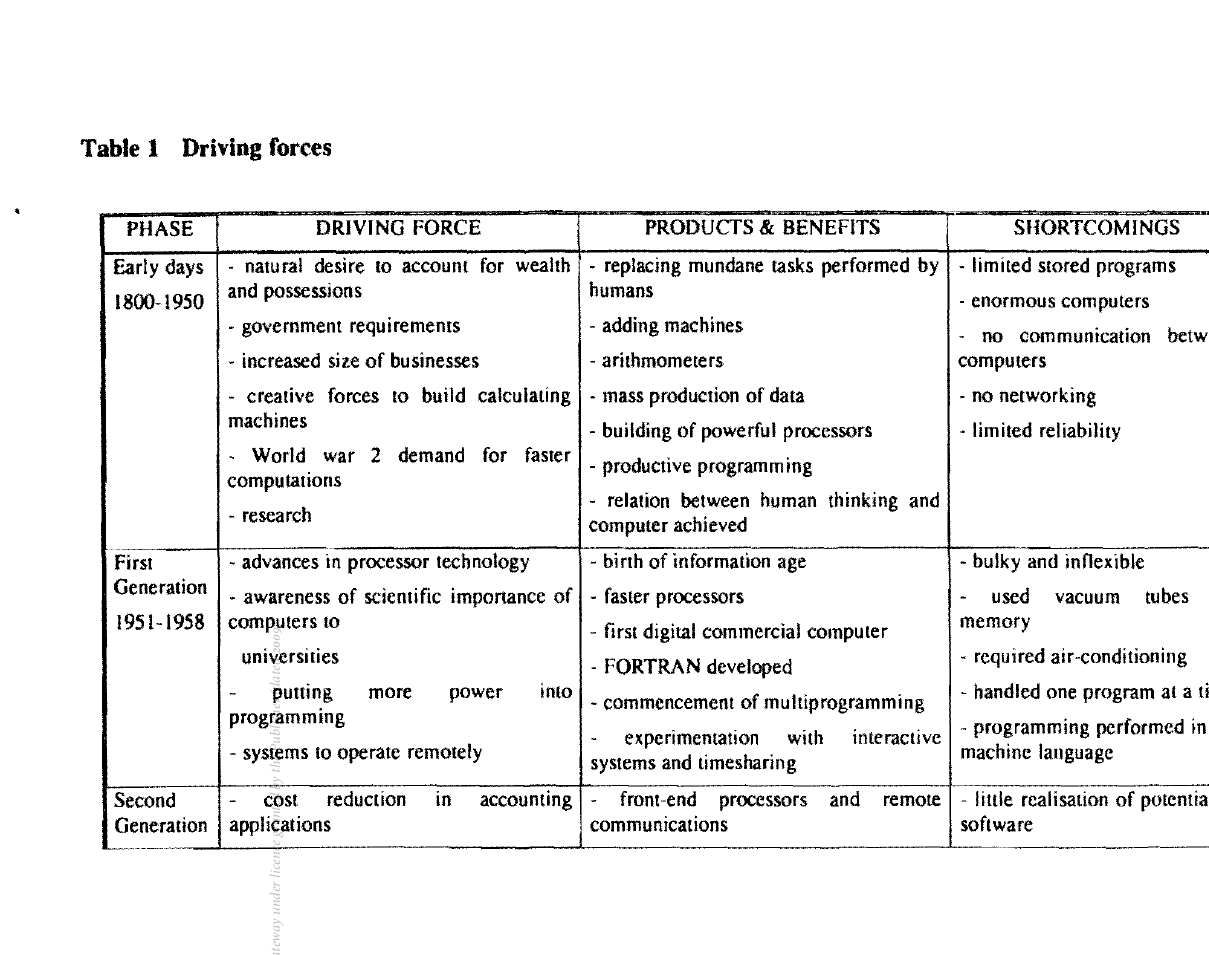
Table 1 Driving